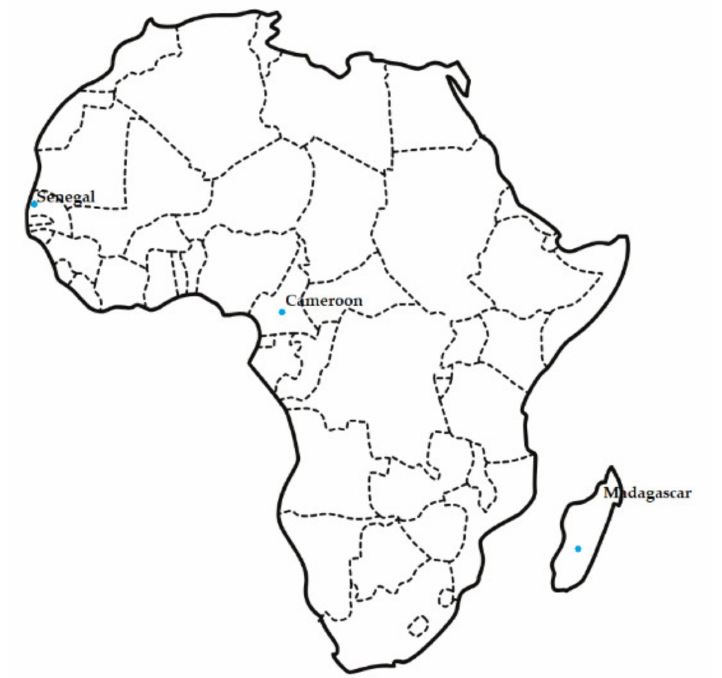
Figure 2. Location of three studied cities.